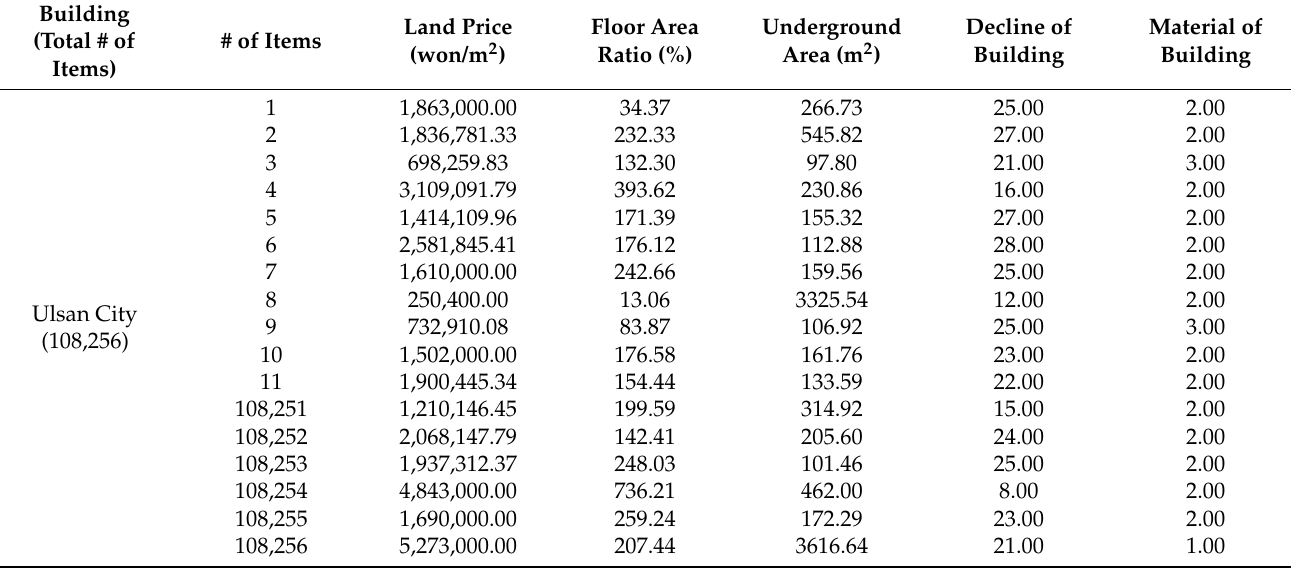
Table 3. Database for building unit